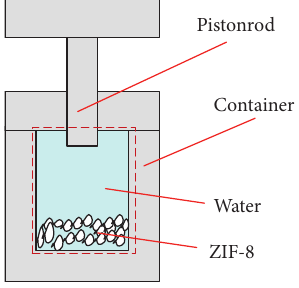
Figure 4: Schematic diagram of the ZIFI.